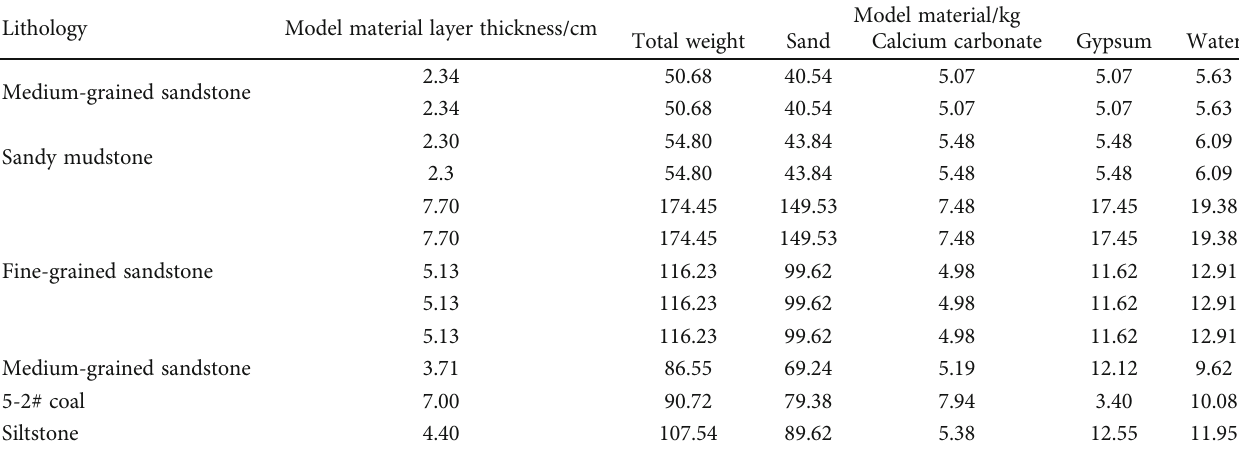
Figure 3: Diagram of a similarity experimental model. Table 1: Similarity material ratios for each rock